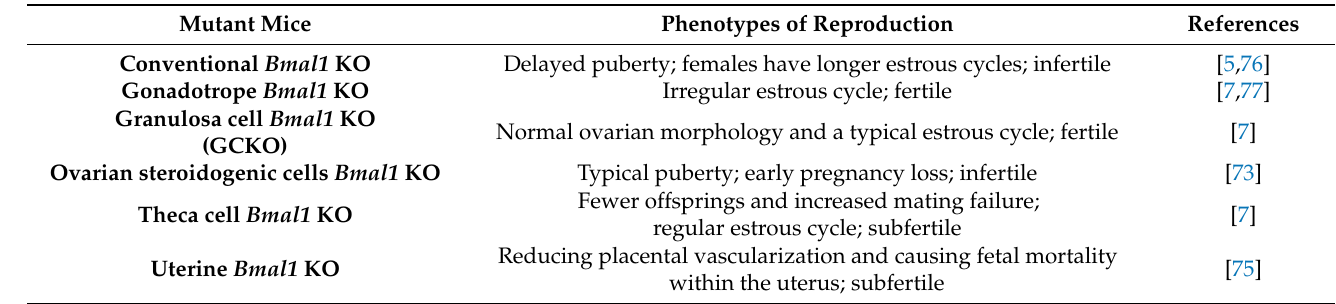
Table 1. Distinct reproductive characteristics of Bmal1 mutant